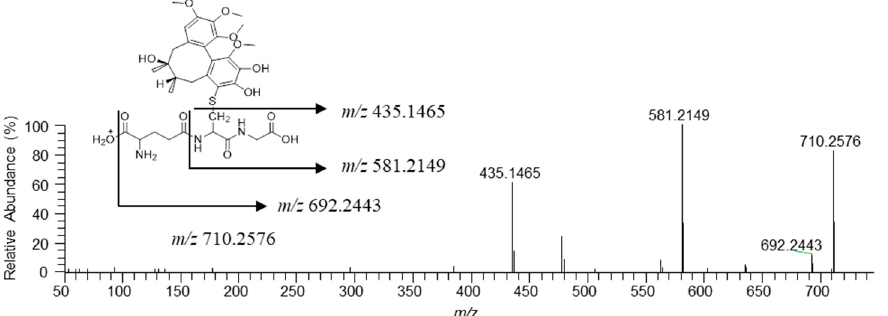
Figure 2. MS/MS spectrum of glutathione conjugate of gomisin A annotated with the proposed structures of fragment ions obtained by UPLC-HRMS analysis of the human recombinant CYP2C8 incubates of gomisin A in the presence of NADPH generating system and glutathion.